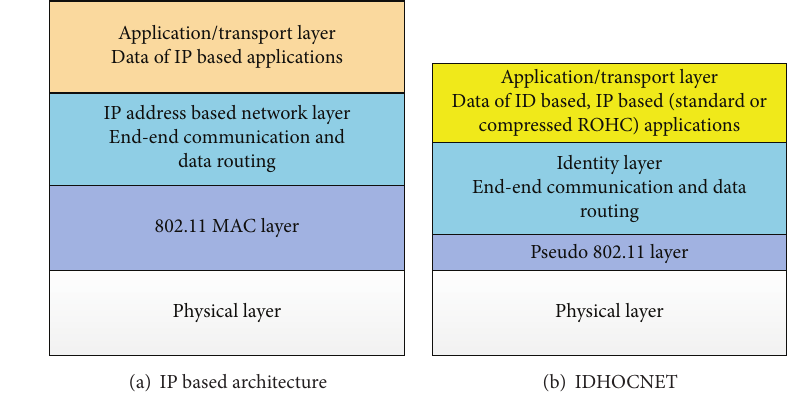
Figure 9: IP Vs IDHOCNET protocol stack